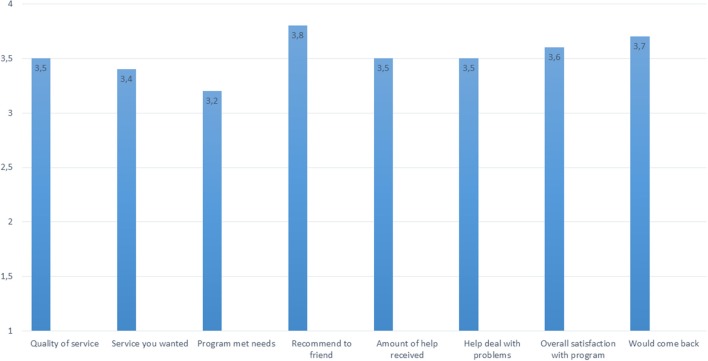
Acceptance and satisfaction with treatment program (CSQ-8). How would you rate the quality of service you have received?: 3.5 (SD = 0.6). Did you get the kind of service you wanted?: 3.4 (SD = 0.5). To what extent has our program met your needs?: 3.2 (SD = 0.7). If a friend were in need of similar help, would you recommend our program to him or her? 3.8 (SD = 0.4). How satisfied are you with the amount of help you have received?:3.5 (SD = 0.5). Have the services you received helped you to deal more effectively with your problems?: 3.5 (SD = 0.6). In an overall, general sense, how satisfied are you with the service you have received?:3.6 (SD = 0.5). If you were to seek help again, would you come back to our program? 3.7 (SD = 0.5).